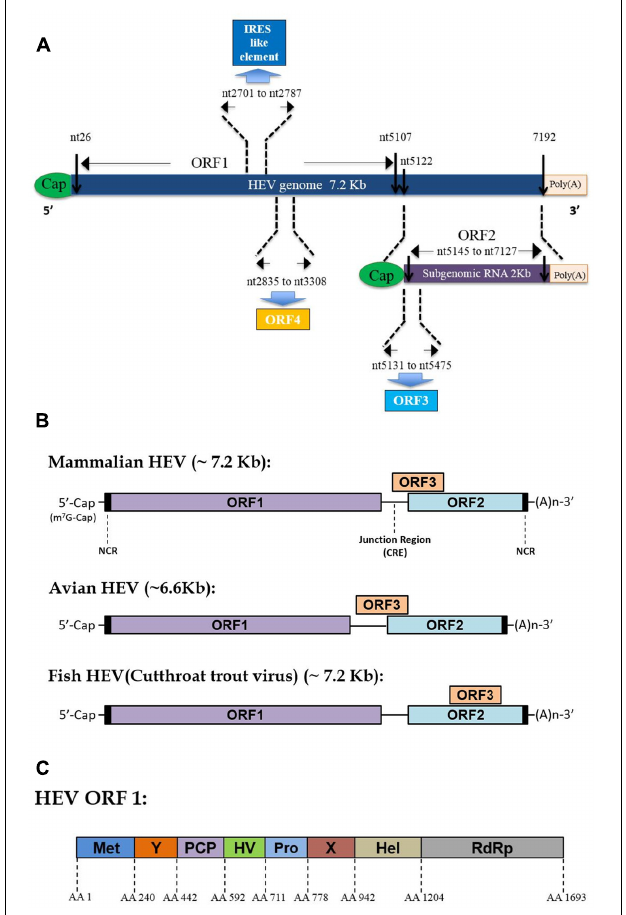
FIGURE 1 | Hepatitis E virus (HEV) genome organization and function domain encoded by mammalian HEV ORF1. (A) Schematic illustration of HEV genome organization and subgenomic RNA. ORF1 (nt 26–5107) is labeled above the genomic RNA box. ORF2 (nt 5145–7127) and ORF3 (nt 5131–5475) are encoded by the same subgenomic RNA. The numbers above or below the RNA boxes indicate nucleotide numbers of the cDNA of HEV Sar55 (Genotype 1 Orthohepevirus A virus, GenBank accession # AF444002). (B) Genome location of ORF3 among different Hepevirus virus. (C) Schematic illustration of function domains encoded by mammalian HEV ORF1 polyprotein. Met, methyltransferase domain; Y, Y domain; PCP, papain-like cysteine protease; HV, hypervariable region; Pro, proline-rich domain; X, X-domain; Hel, helicase; RdRp, RNA-dependent RNA polymerase. The numbers above the box indicate amino acid residues encoded by of ORF1 of HEV Sar55 strain (Genotype 1 Orthohepevirus A